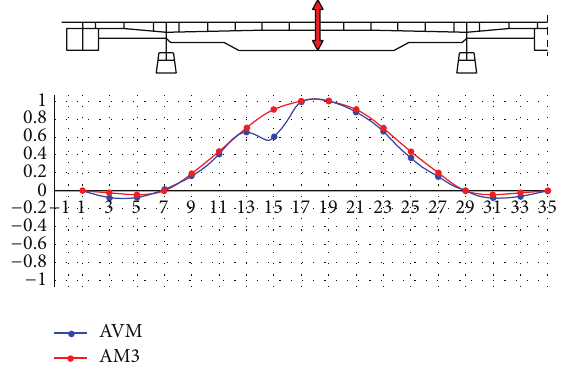
Figure 27: Experimentally and mathematically identified second vertical mode shapes.